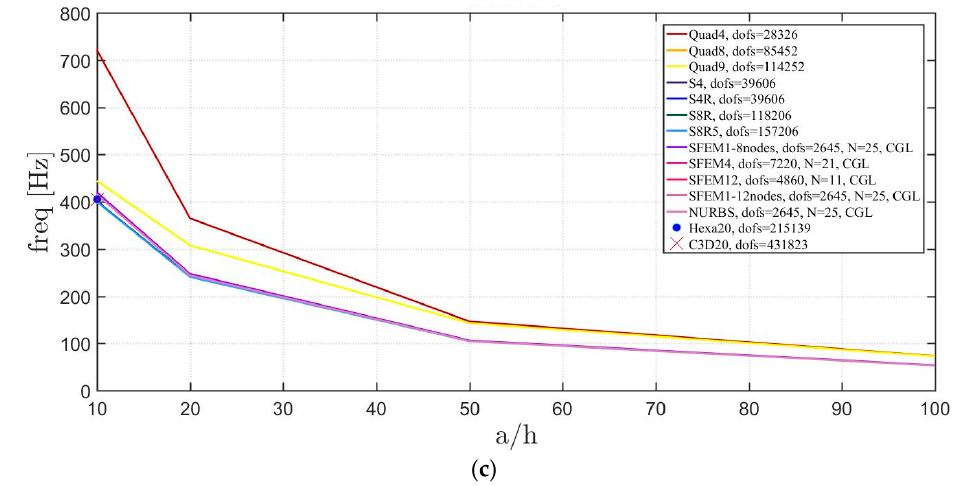
Figure 19. Thickness effect on the first three natural frequencies of a circular plate with a symmetric lamination scheme: ( a ) First frequency; ( b ) Second frequency; ( c ) Third frequency.